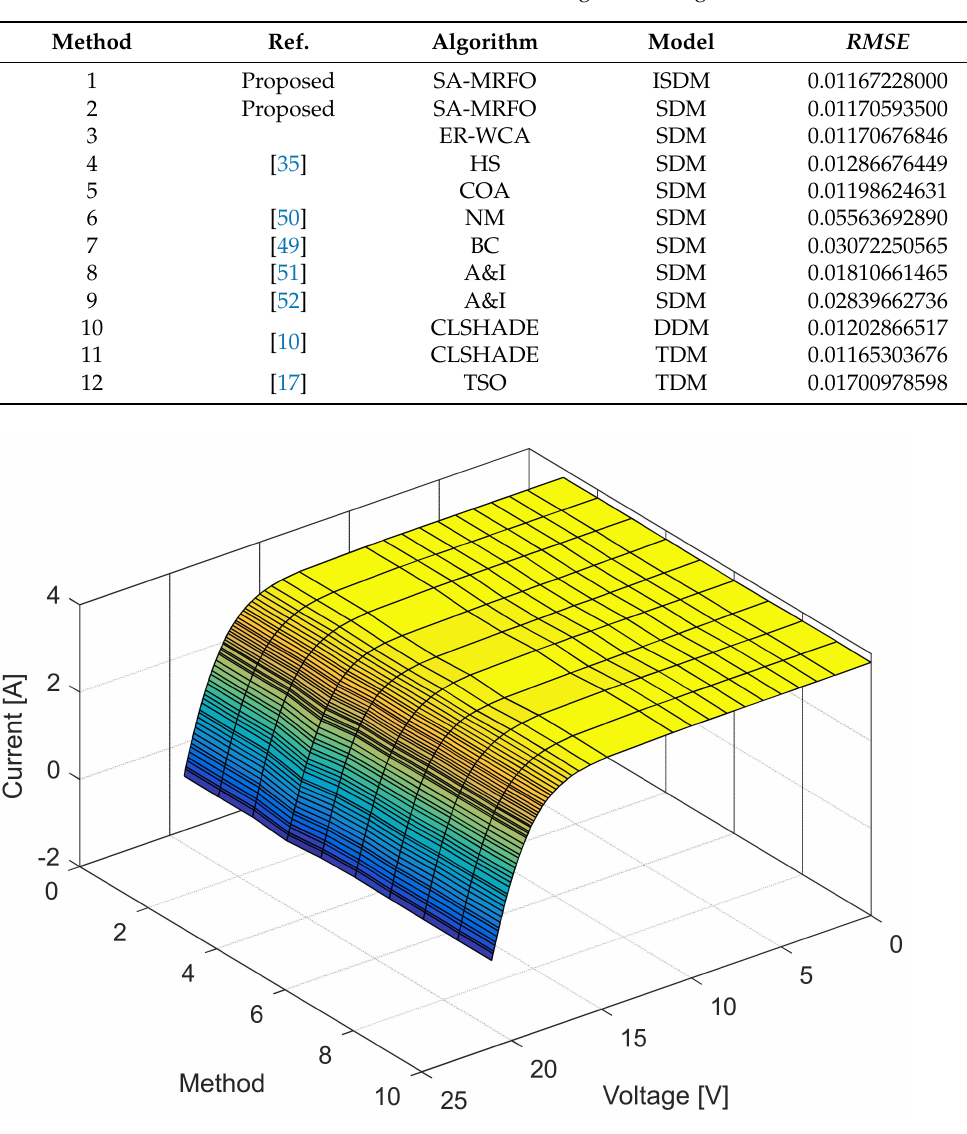
Figure 16. Current–voltage characteristics for the methods listed in Table